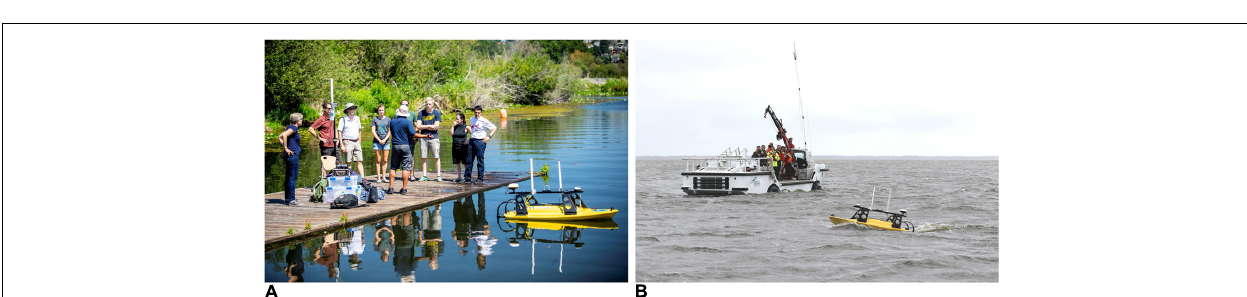
FIGURE 1 | StreetView images acquired with RAPID equipment during a STEER reconnaissance mission in Mexico Beach, FL, following Hurricane Michael (Roueche et al., 2020).